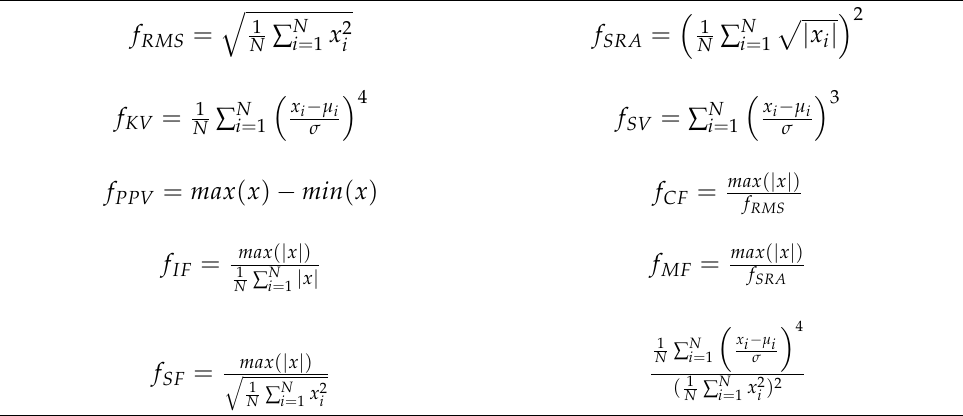
Table 6. Time-domain feature definitions used for N data points in a sample X .